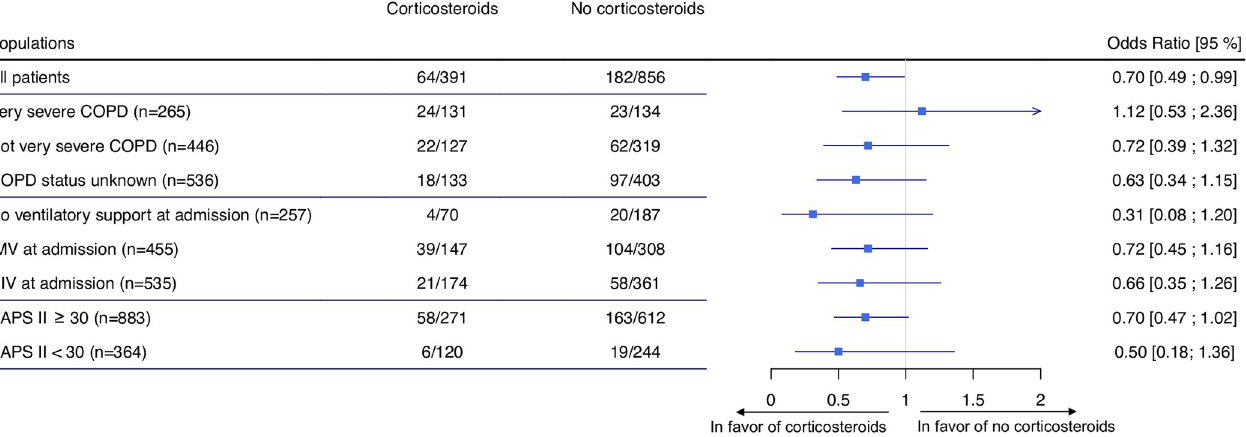
PLOS ONE | https://doi.org/10.1371/journal.pone.0284591 April 19,